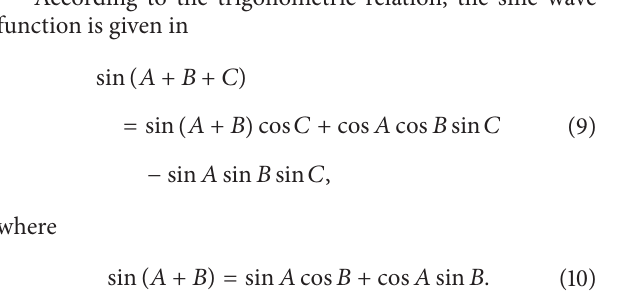
𝐵 < (𝜋/2) ∗ (1/2 𝐴 ) , and 𝐶 < (𝜋/2) ∗ (1/2 𝐴+𝐵 ) , with the same approximations based on trigonometric